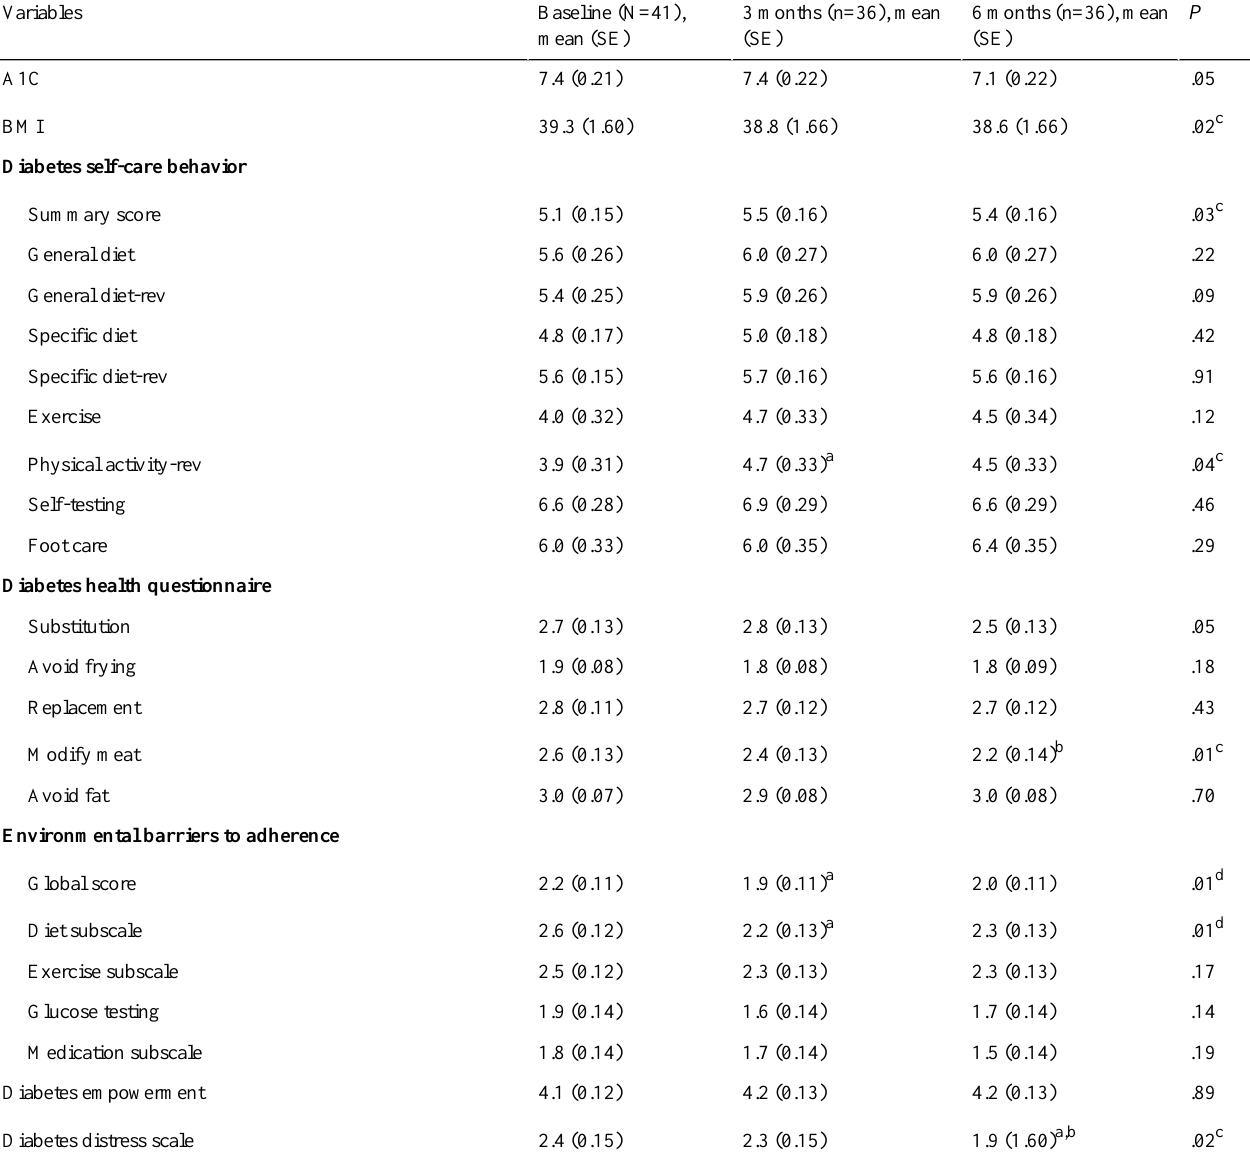
Table 4. A1C, BMI, self-care, and psychosocial measures across time, baseline through 6